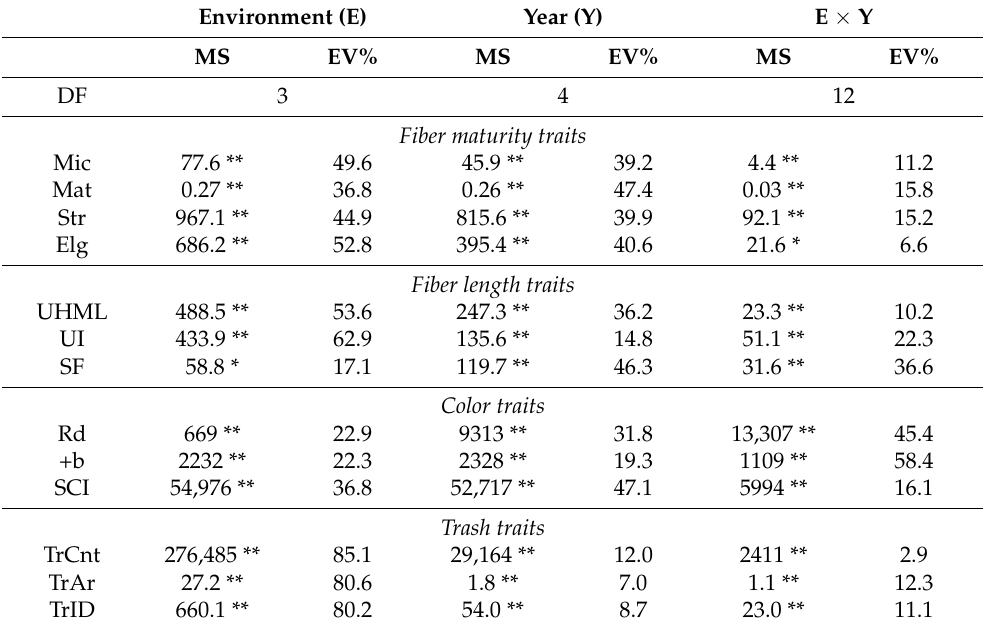
Table 3. Combined analysis of variance for various cotton physical measurements produced across four environments for five